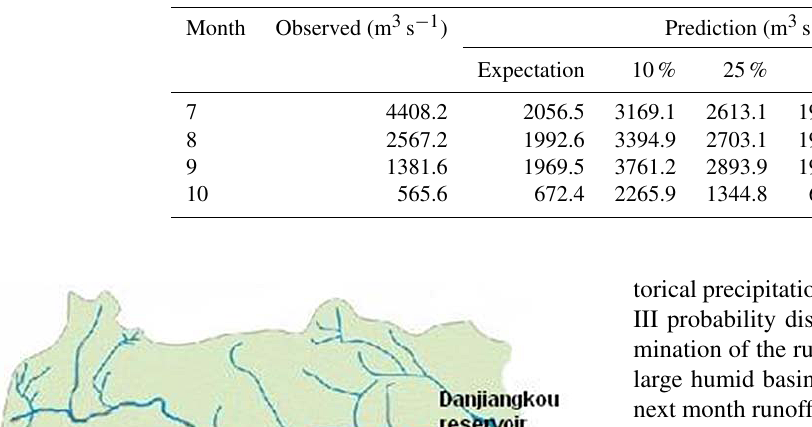
Table 1. Observed and predicted monthly discharge from July to October 2007 at the Danjiangkou reservoir.